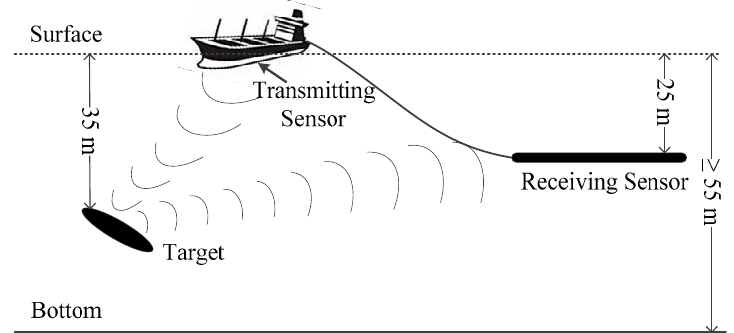
Figure 12. The sea trial installation.